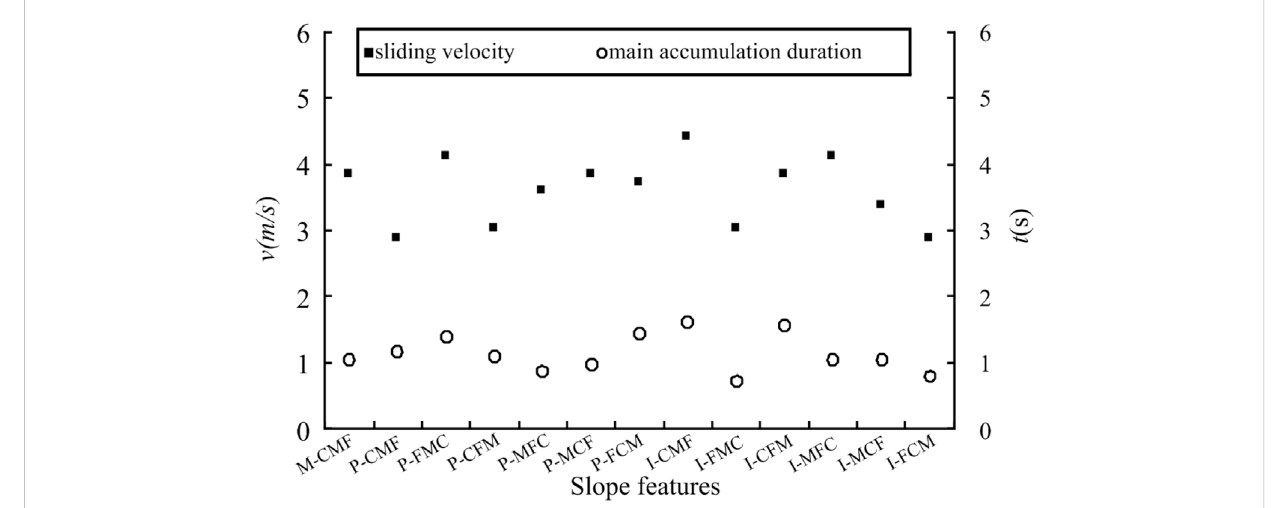
FIGURE 11 Average velocity and accumulation stage duration of a landslide under different slope